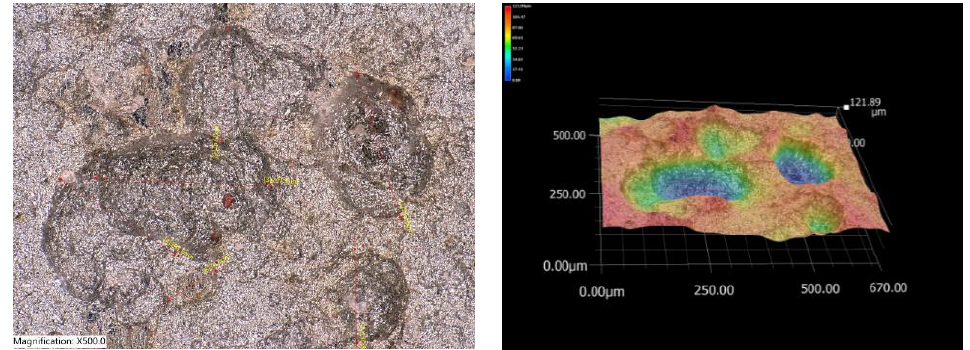
Figure 8. Structure of the steel surface under the corrosion layer. Table 1. Pitting in steel surface after removal of corrosion products.